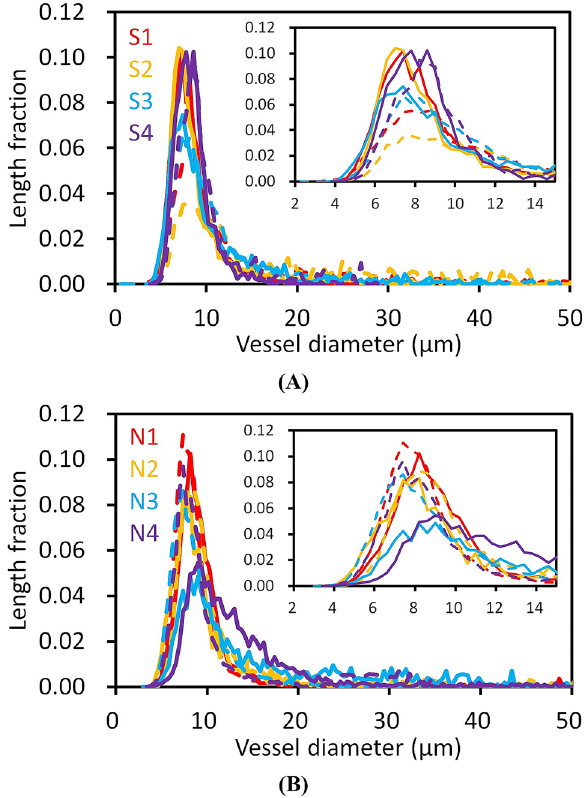
Figure 2. Vessel diameter distribution. The frequency distribution in each 0.4-μm diameter bin is represented by the length fraction, which was calculated by dividing the vessel length per bin by the total vessel length. Insets show magnifications of capillary peaks. Schizophrenia cases S1–S4 and controls N1–N4 are color-coded. Solid lines represent BA22 distributions, and dashed lines represent BA24 distributions. ( A ) Diameter distribution of the schizophrenia cases. ( B ) Diameter distribution of the control cases.